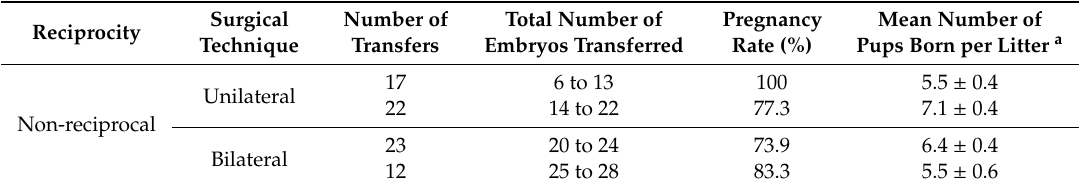
Table 1. Genetically engineered mice at a C57BL / 6J background transfers, grouped by number of embryos.